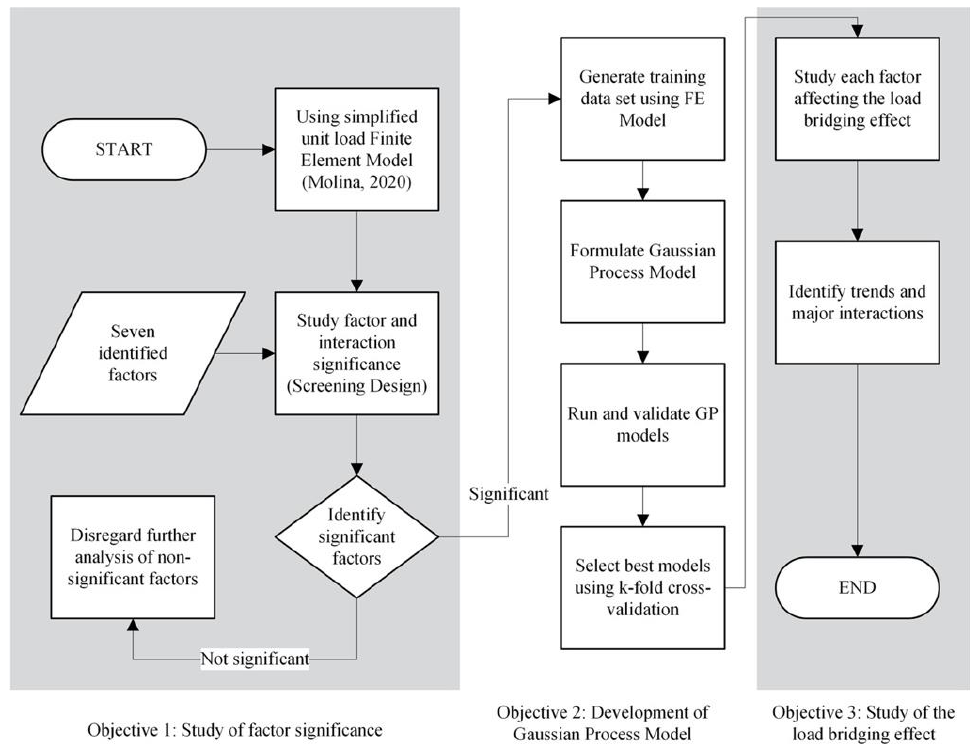
Figure 1. Steps followed to study the effect of load bridging on racked unit loads.